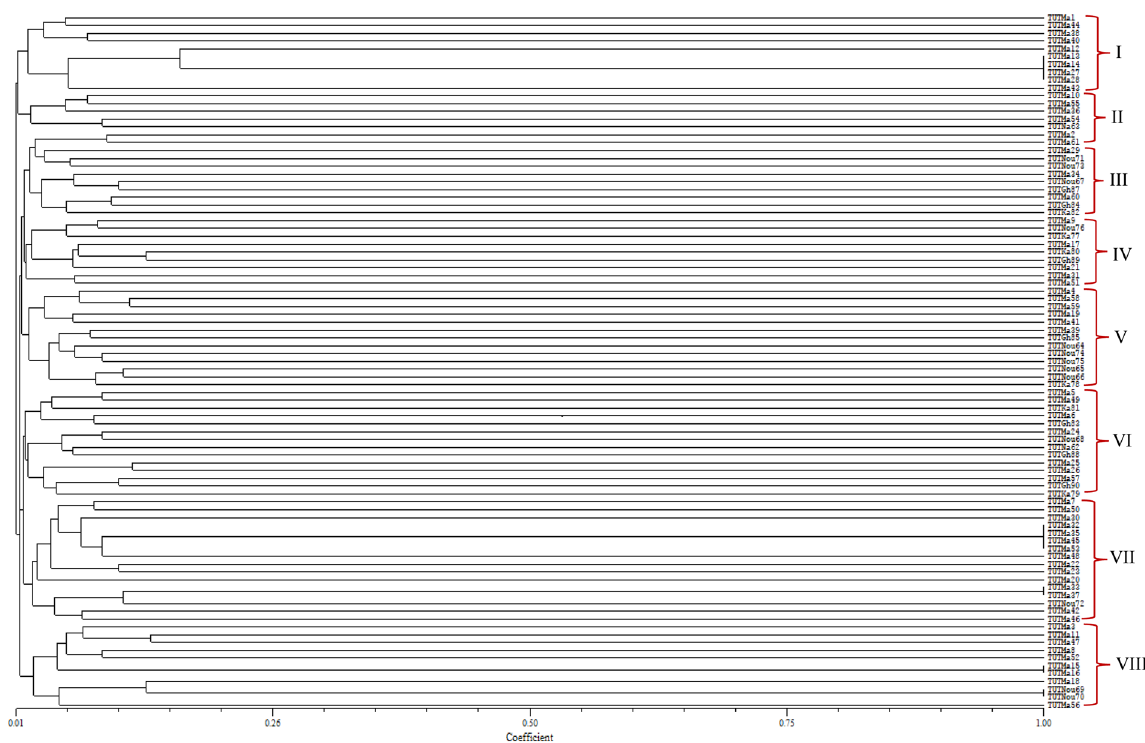
Figure 2. A dendrogram generated from ERIC-PCR banding patterns of 89 Bambara groundnut rhizobial isolates. The lengths of the separated DNA amplified fragments on the gel were calculated using Image Lab software (Bio Rad, USA). The fragment length was used to construct a dendrogram using Jaccard’s similarity coefficient with NTSYSpc 2.1 software.